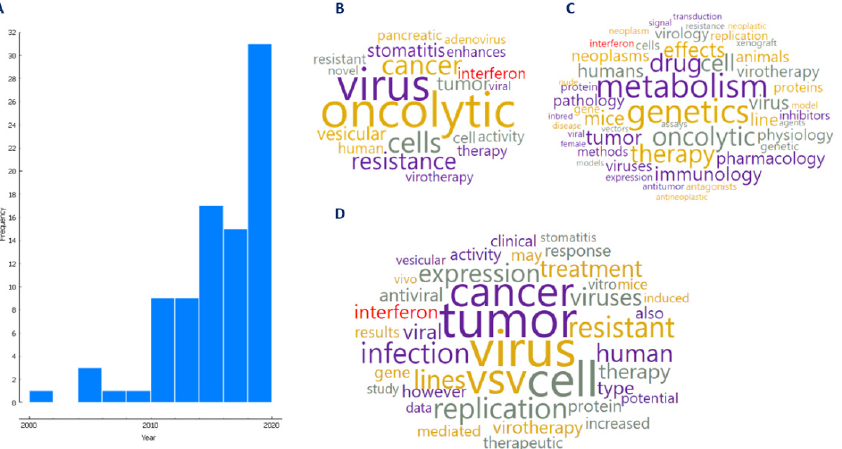
Figure 2. Literature review in the context of resistance to oncolytic viruses. ( A ) Number of original research articles (a total of 87) that studied resistance to virotherapy in the context of cancer from 2000 to 2020. ( B ) Frequently used terms in article titles, ( C ) MESH heading terms, and ( D ) abstracts. These 87 articles were published in more than 40 journals by various authors. Seven ‐ teen viral vector types (natural or genetically modified) were studied in relation to re ‐ sistance developed in twenty ‐ two cancer types represented by hundreds of cell lines and preclinical animal models. This analysis also indicated an increasing interest in under ‐ standing the role of therapeutic resistance towards oncolytic viruses since the last decade (since 2010). Resistance mechanisms could be classified based on molecular features along with cellular mechanisms and cell ‐ type ‐ specific mechanisms (indicated in Figure 3A,B).